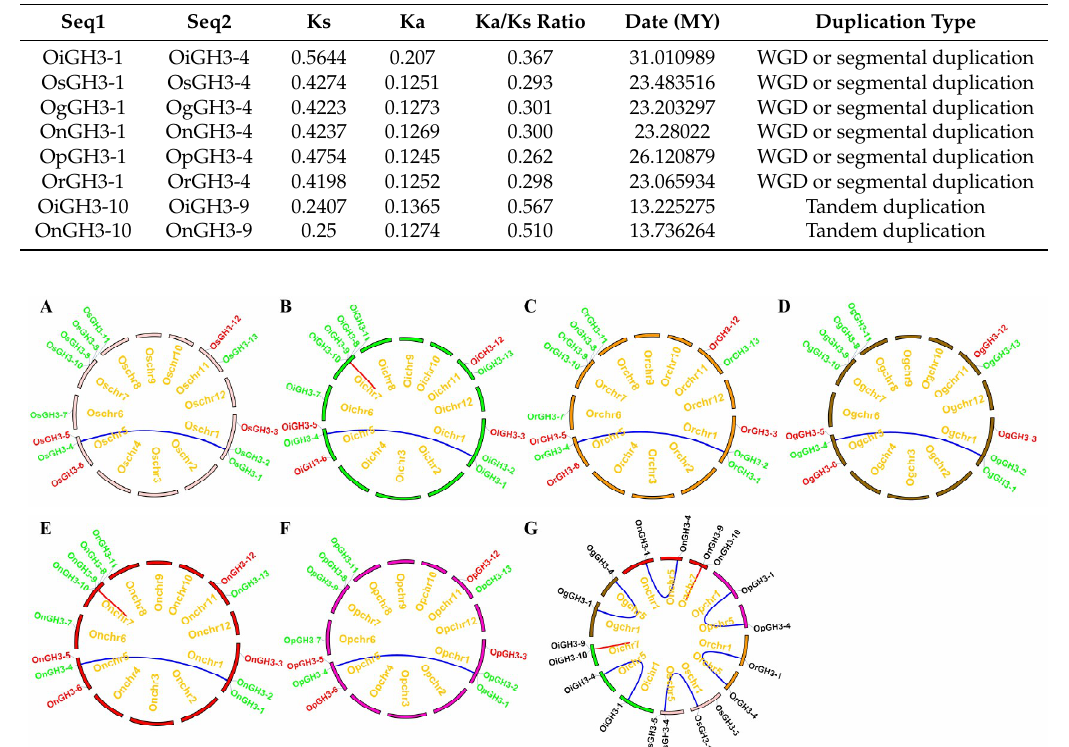
Figure 3. The chromosome location and duplication events of GH3 genes in six species/subspecies ( A–F ), and duplication events in six Oryza species/subspecies ( G ). Os represents Oryza sativa ssp. japonica . Oi represents Oryza sativa ssp. indica . Or represents Oryza rufipogon . On represents Oryza nivara . Op represents Oryza punctata . Og represents Oryza glumaepatula . The chromosomes of different Oryza species/subspecies are shown by different colors. The location of each GH3 gene is marked with a grey line using Circos software. The whole genome duplication (WGD) or segmental duplication/Tandem duplication gene pairs are linked by blue/red lines. The red and green genes in A–F belong to group1 and group2, respectively.